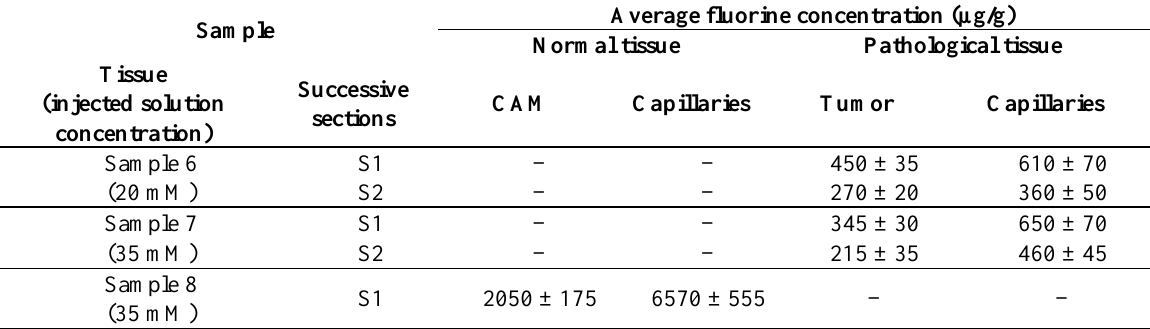
Table 3. Fluorine concentrations in normal and tumor tissues exposed to fluorinated CBO-P11 solutions (20 and 35 mM). Average fluorine concentration (µg/g) Sample Normal tissue Pathological tissue Capillaries Tumor